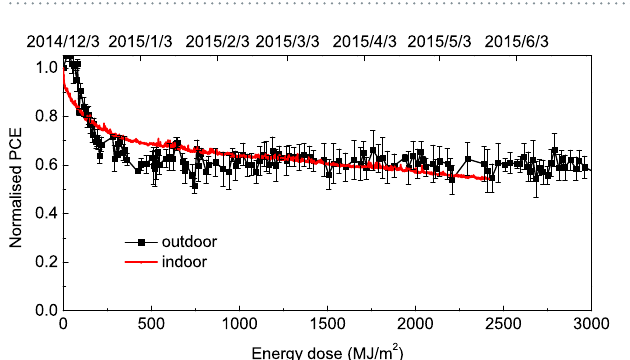
Figure 5. Evolution of the device metrics on testing using the indoor accelerated testing system normalised to initial values as a function time.